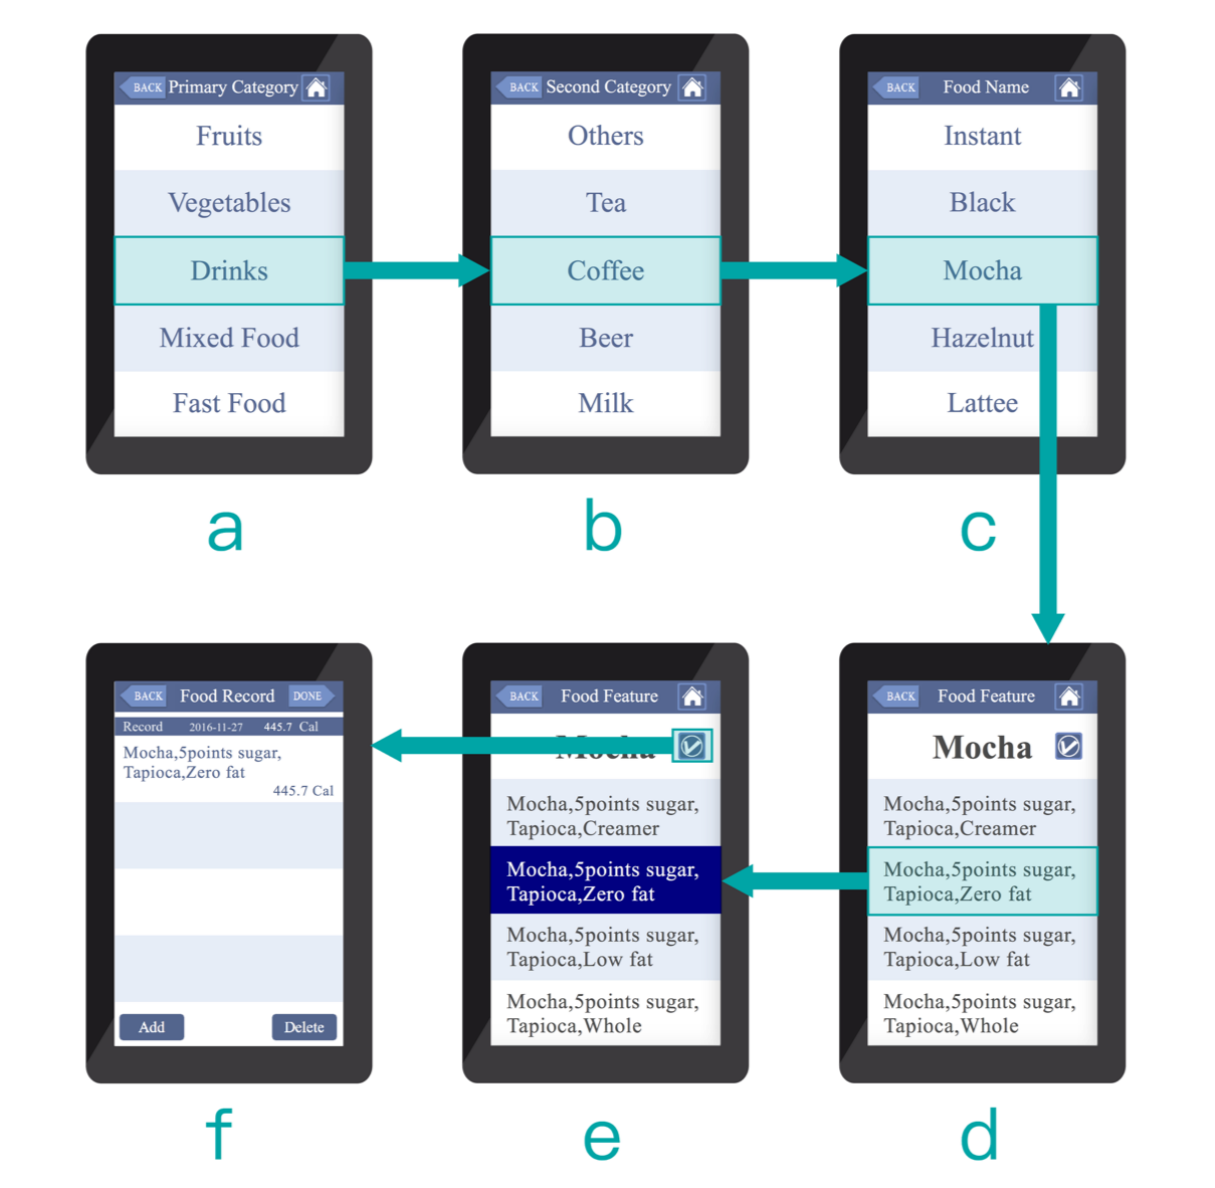
Figure 2. The autonomous exhaustive list interface design and